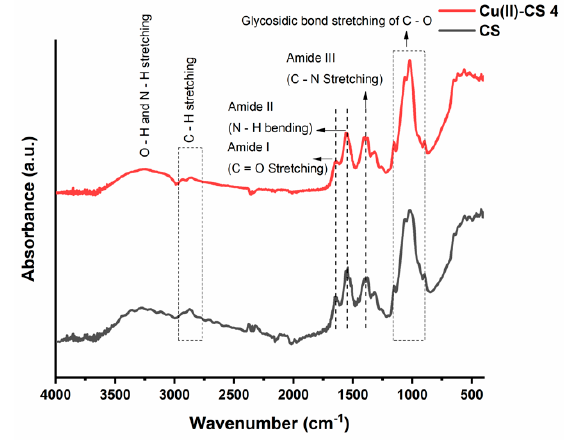
Figure 3. Fourier-transform infrared (FTIR) spectra of CS and Cu(II)–CS4 coatings. The relevent peaks are discussed in the text.